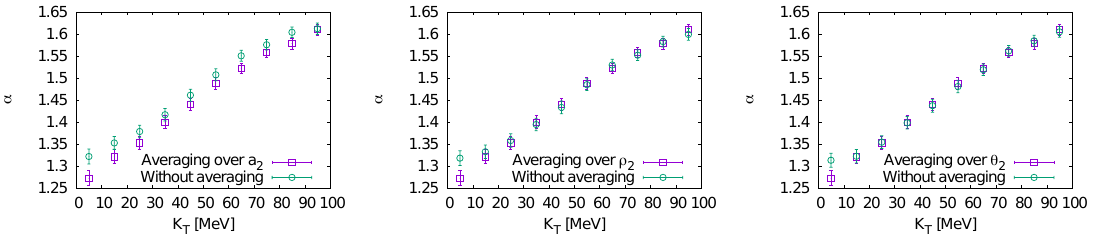
Figure 1. The Lévy parameter of the 1D fits to the correlation function in q inv . Mean transverse momentum K T in bins of 10 MeV. A green circle shows results calculated with fixed anisotropies. The purple data show results calculated for averaging over a 2 ( left ); averaging over ρ 2 ( middle ), and averaging over θ 2 ( right ). Vertical error bars show the 1 σ intervals, resulting from fitting the correlation function with the ansatz of Equation (19).